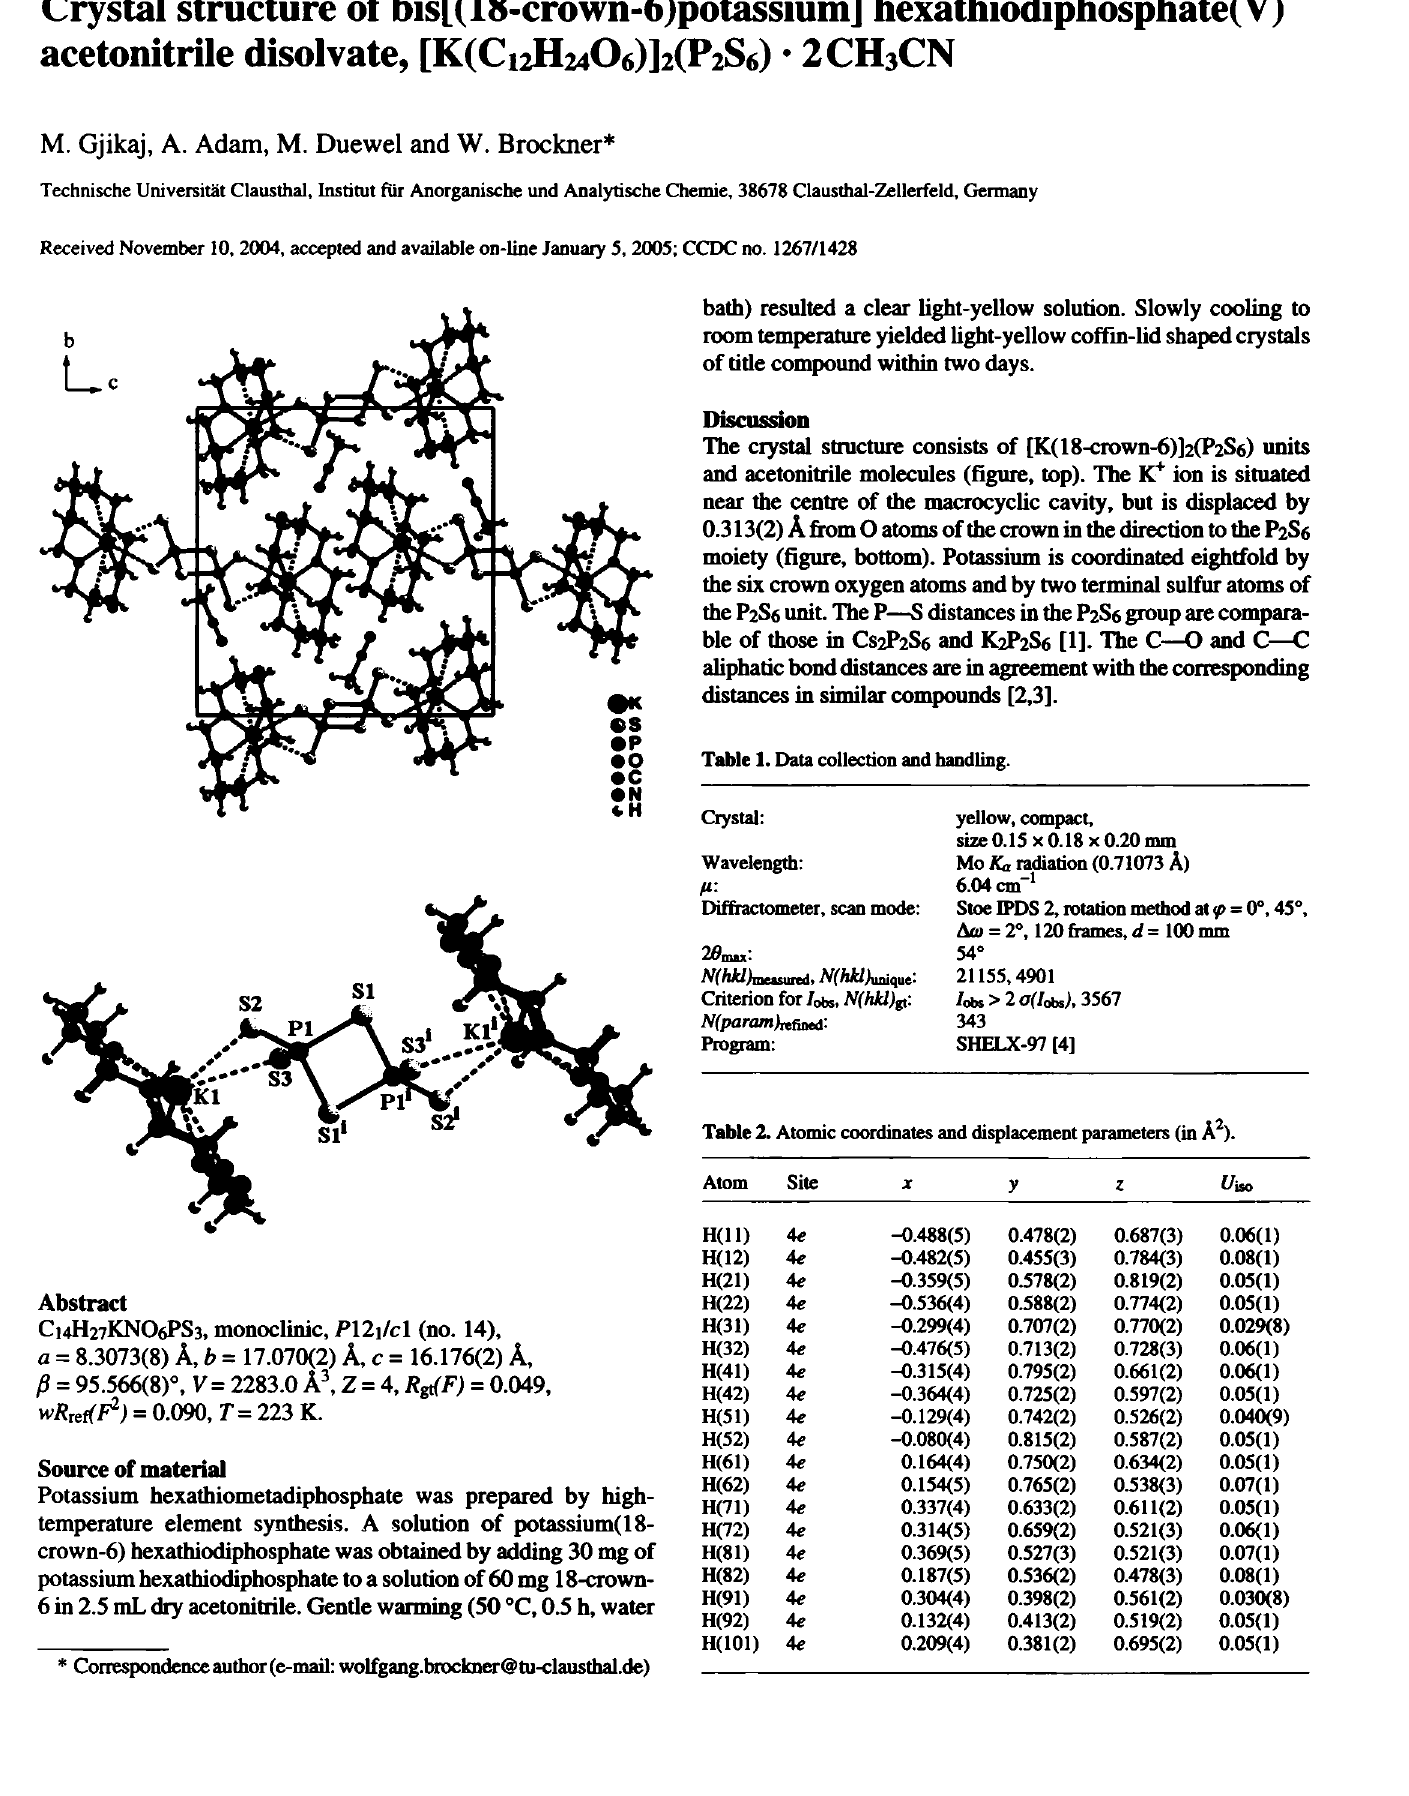
Table 2. Atomic coordinates and displacement parameters (in A 2